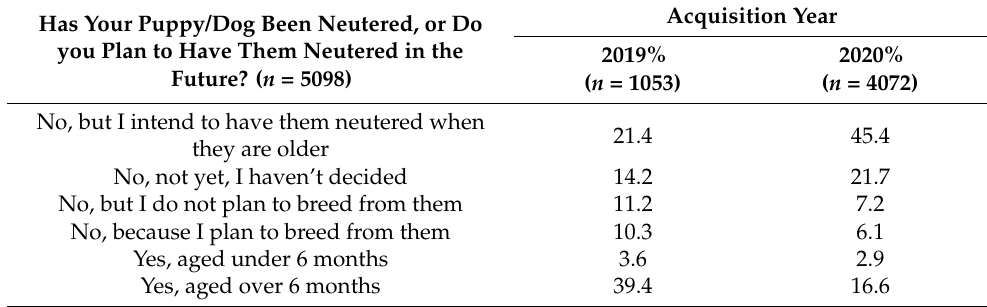
Table 7. Neuter status of 2019 puppies ( n = 1053) and Pandemic Puppies ( n = 4072) as reported by their owners at the time of the survey in response to the question “Has your puppy/dog been neutered, or do you plan to in the future”. The answer options listed represent all the choices available to respondents.